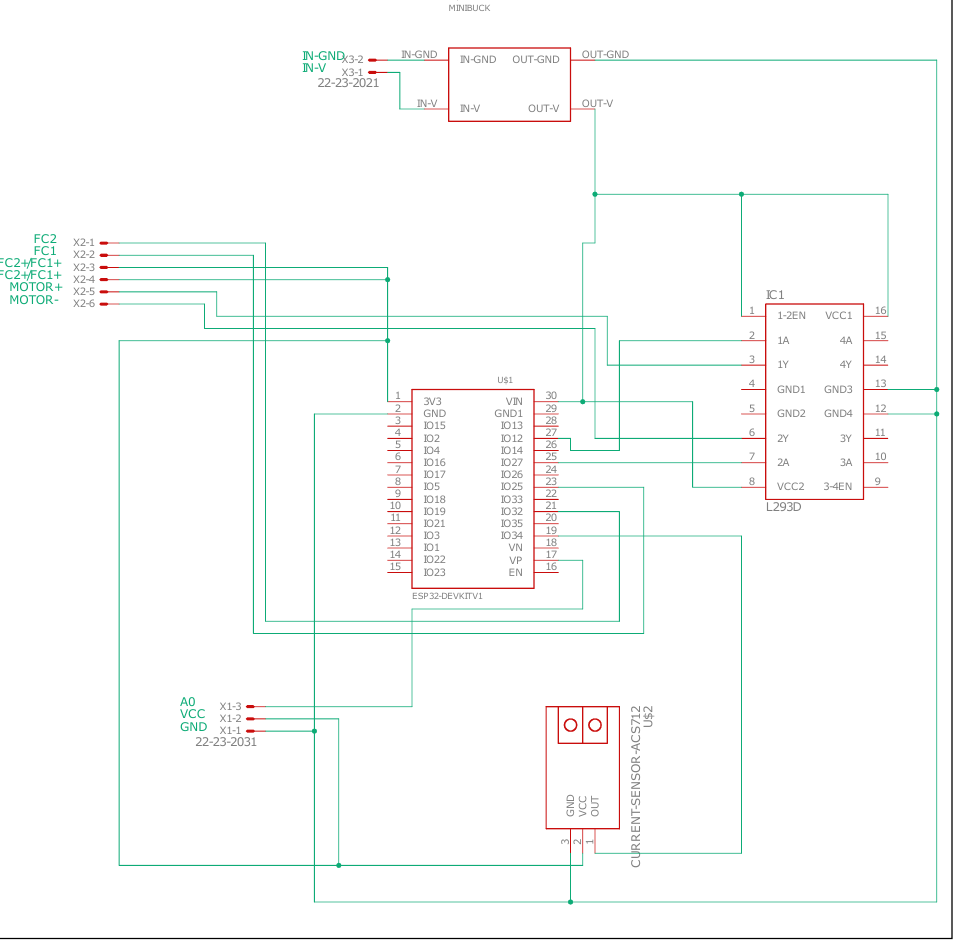
Figure 12. Electronic design of the main